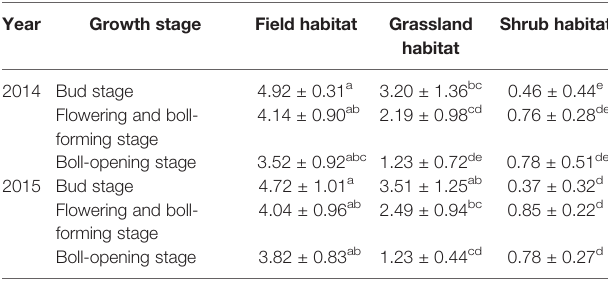
TABLE 3 | Content of Bt protein in the leaves of Zhong30 plants at different experiment sites during the different growth stages ( m g/g fresh mass) (mean ±